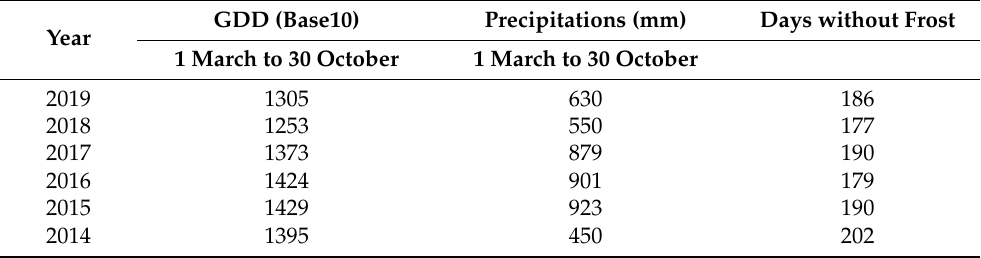
Table 3. Climatic conditions in Oka vineyard during 2014 to